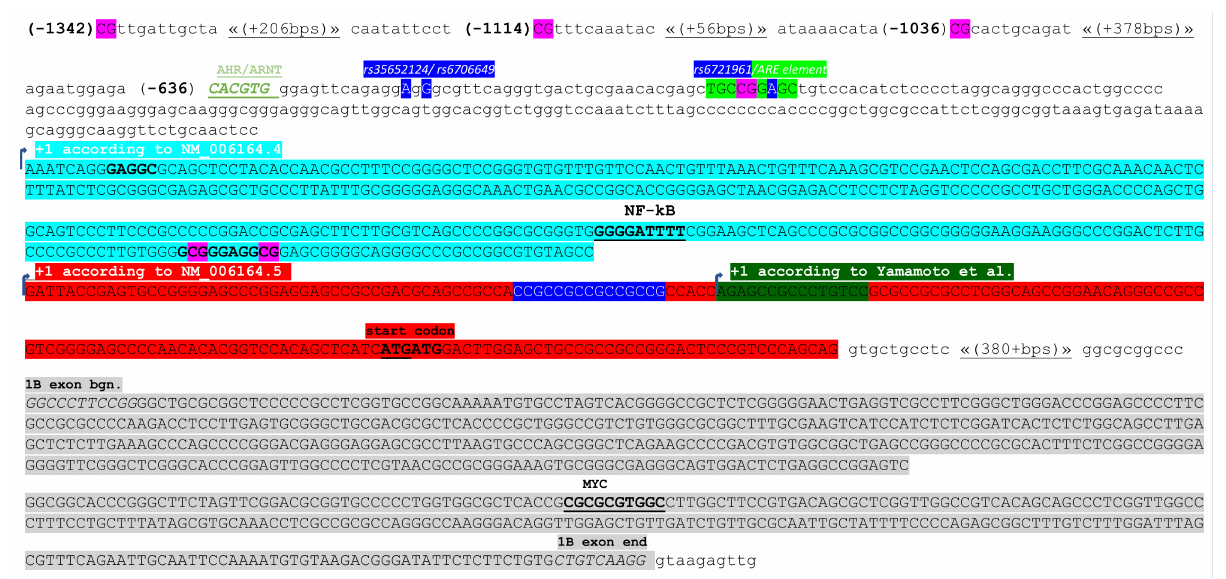
Figure 2. NRF2 promoter, presented from − 1342. The most current TSS is presented in red highlight (NM_006164.5), and the previous version is presented in turquois (NM_006164.4). The TSS described by Yamamoto is shown in green highlight [89]. Differentially methylated CG spots are presented in pink, including the one in the ARE element. Transcription factor binding sites for AHR/ARNT (Aryl Hydrocarbon Receptor/Aryl Hydrocarbon Receptor Nuclear Translocator), NF- κ B, and MYC are underlined. ATG: first coding triplet. Polymorphism are presented in a blue